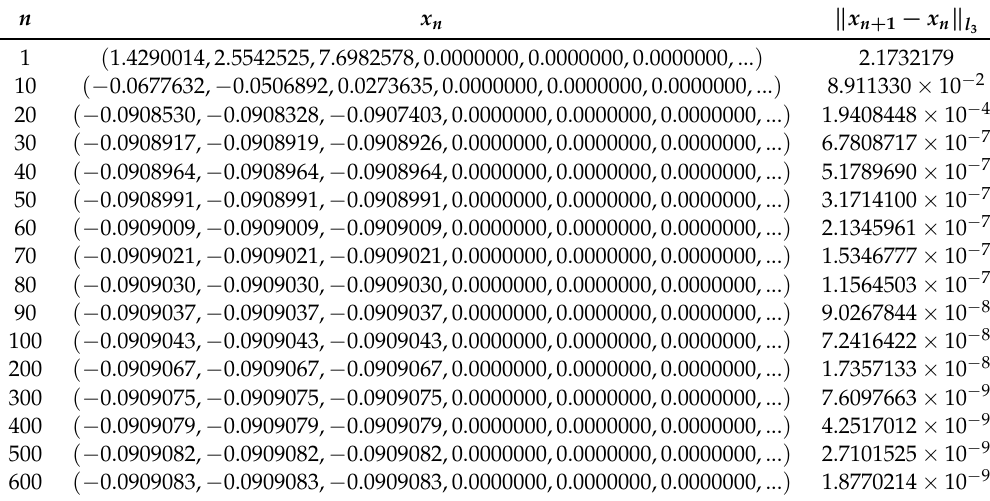
Table 1. Numerical results of Example 1 for iteration process.